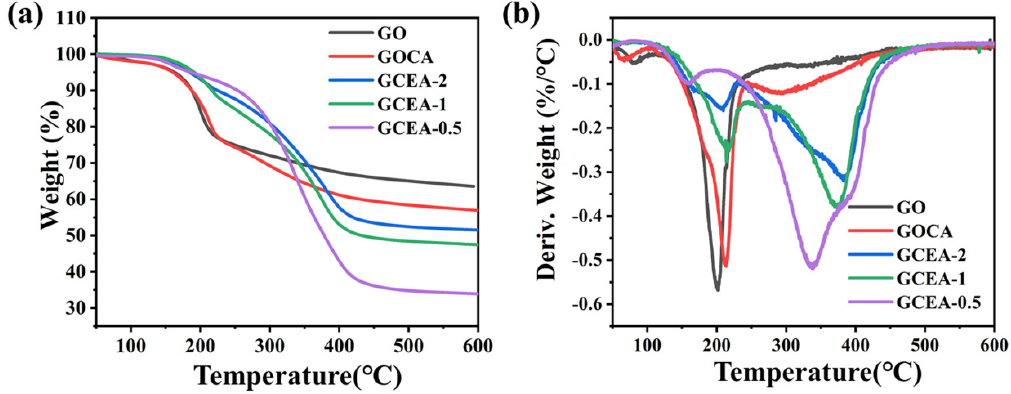
Figure 7. Thermal analysis: ( a ) the TGA curves, and ( b ) the DTG curves (Color figure can be viewed online).